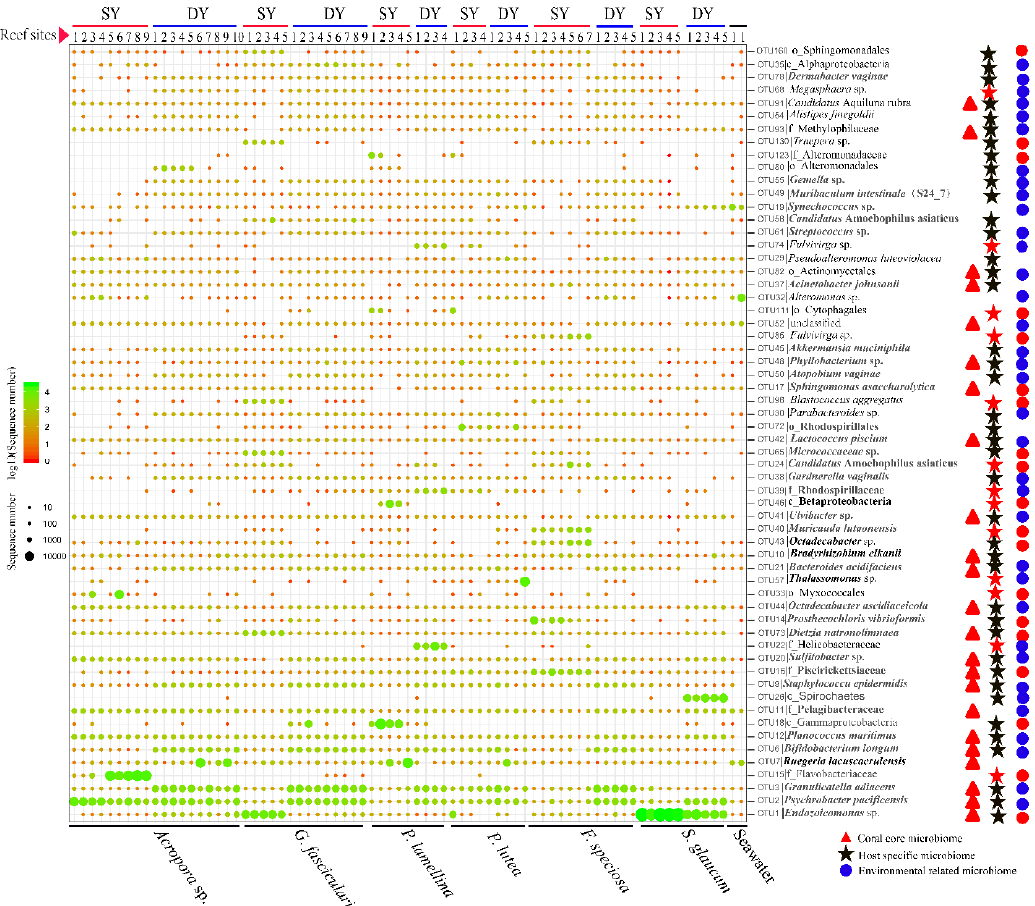
Figure 5. Profiles of the top 60 abundant OTUs affiliated to different bacterial phylotypes detected in explored coral samples. Relative abundance was log10 transformed for plotting. The bottom panel represents coral species. The top panel represents reef sites of each coral species from the tropical SY and subtropical DY reefs. The red triangle of the right panel represents coral core microbiome. The stars represent the host-specific microbiome, and the solid cycles represent environmental related microbiome (red cycles represent coral associated bacteria enriched in the tropical SY reef; blue cycles represent coral associated bacteria enriched in the subtropical DY reef).